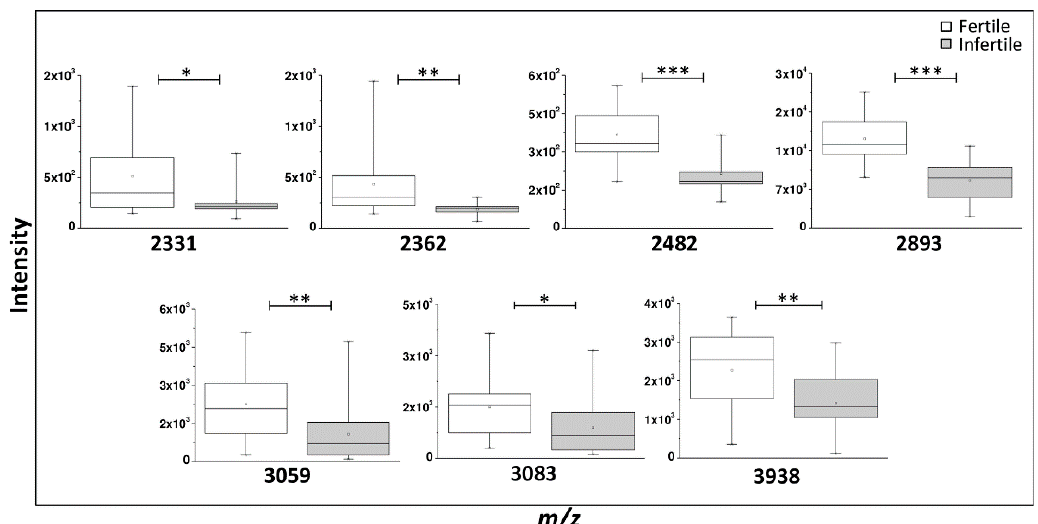
Figure 5. Main discriminant peaks box plot analysis. Box plot of the peak intensities for statistically discriminant m / z signals between 15 fertile and 15 infertile men performed by OriginLab ® software. The p values were calculated with unpaired t -test on normalized peak intensity and the asterisks show the level of significance between the two groups; * p values < 0.01, ** p values < 0.005, *** p values < 0.0001.